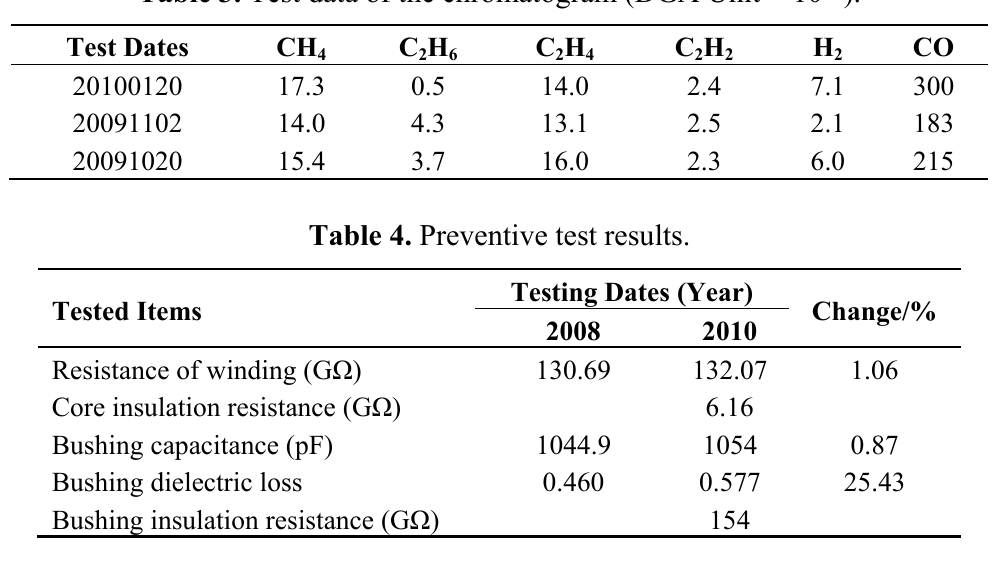
Table 3. Test data of the chromatogram (DGA Unit × 10 − 6 ).